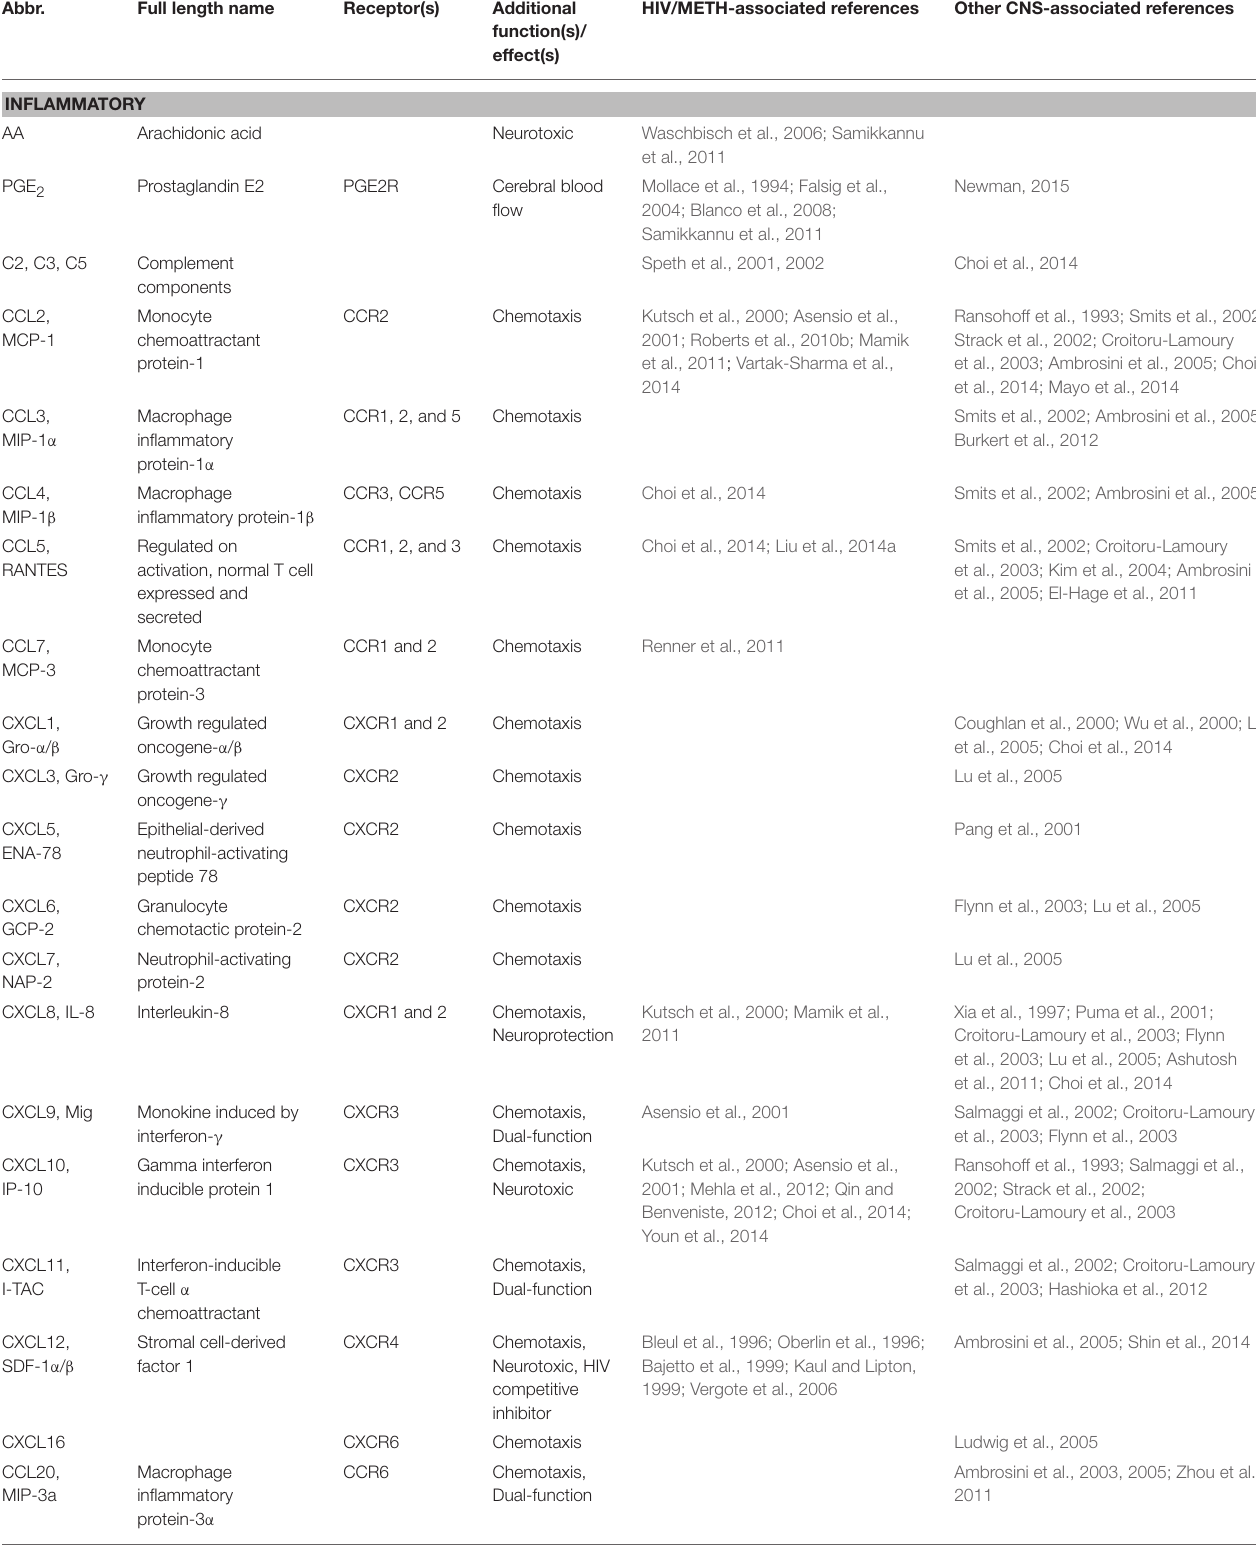
TABLE 1 | Astroglial factors influencing neuronal survival and function.